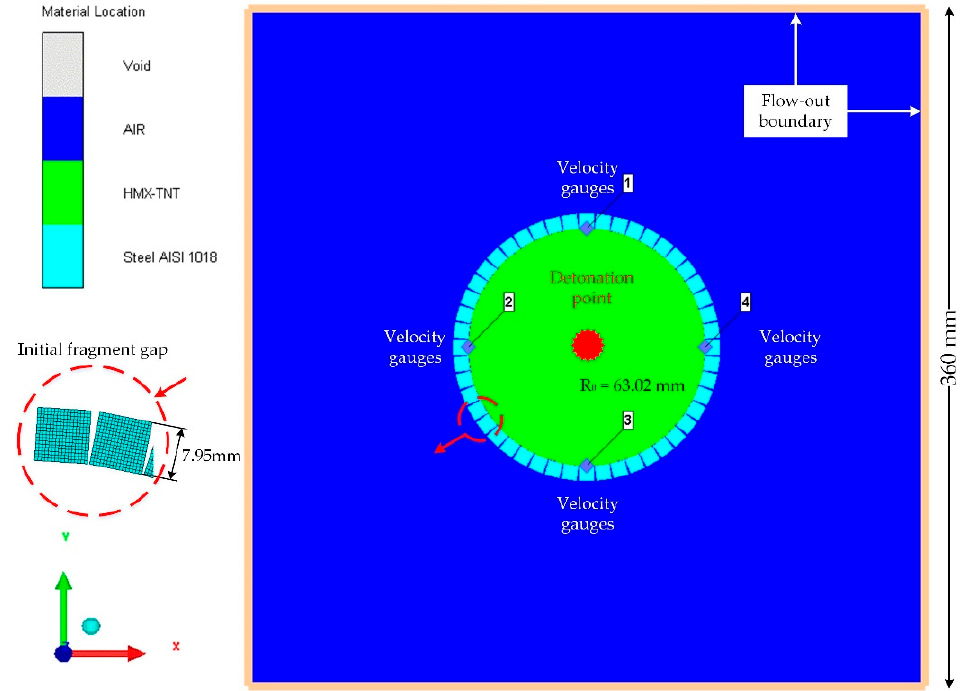
Figure 4. Geometries of the steel preformed-fragment cylinder used in the simulation.